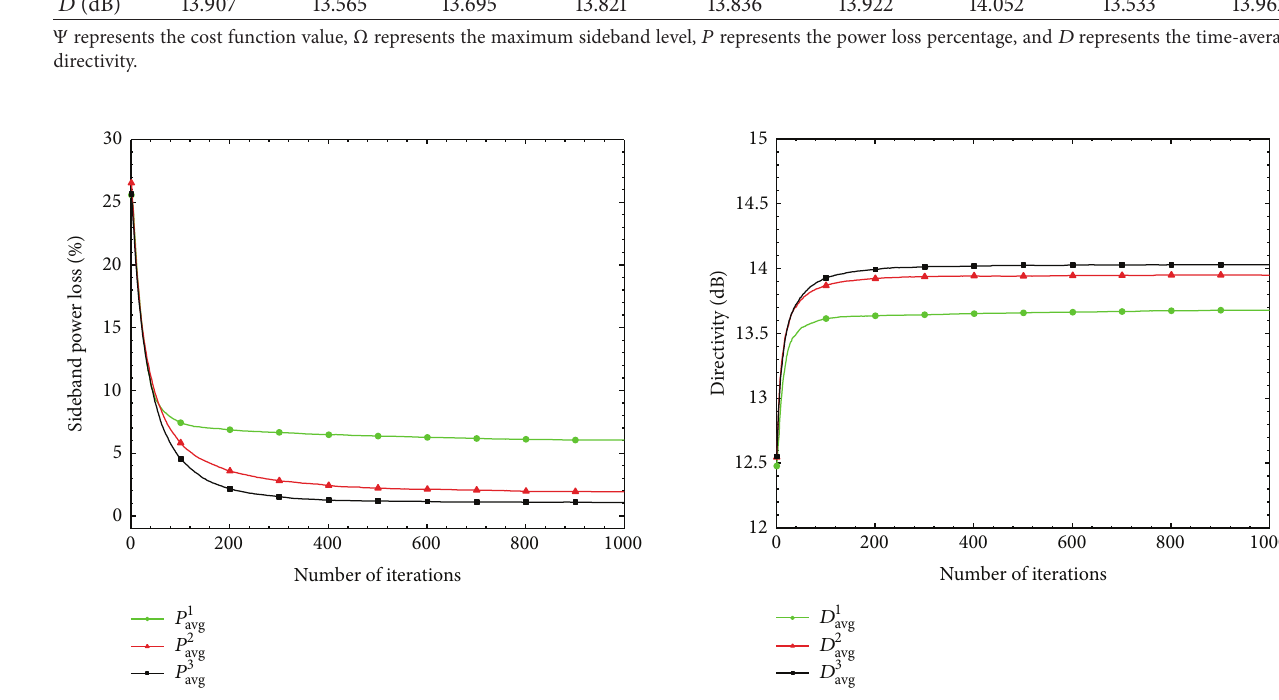
Figure 18: Time-average directivity variation of the three methods for SC— 𝐷 𝑘 represents the time-average directivity and 𝑘 represents the method used, where 𝑘 = 1 : SBL, 𝑘 = 2 : SR, and 𝑘 = 3 : SB.